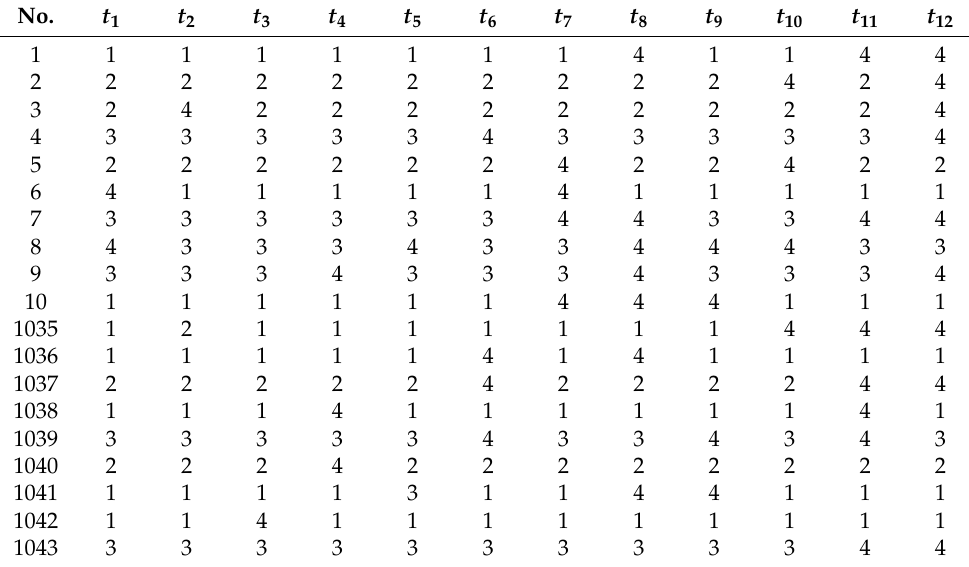
Table 1. Identified topics and topic clustering.